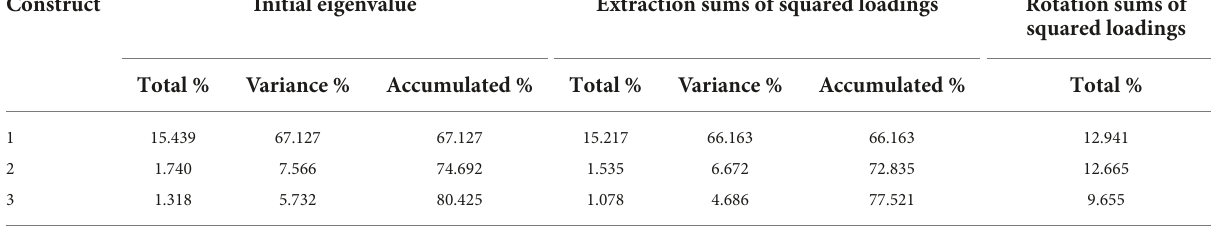
TABLE 4 Total explained variance of the third exploratory factor analysis (EFA).